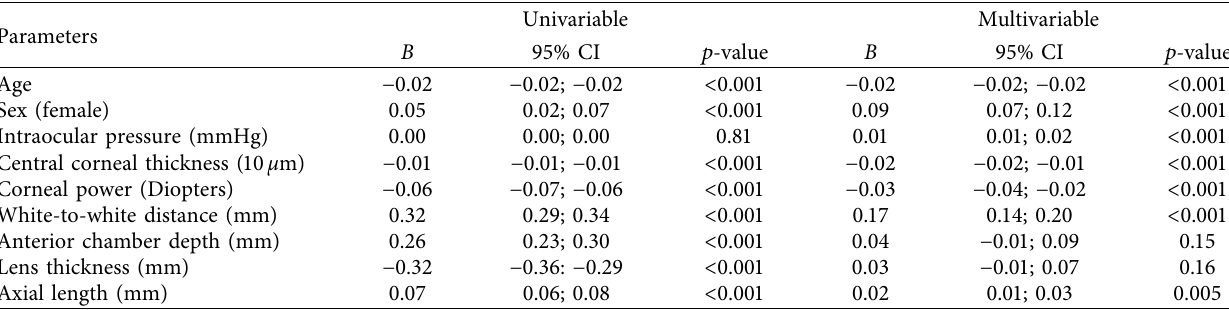
Table 3: Association analysis of ocular parameters and pupil size in phakic subjects. Data from the population-based Gutenberg Health Study in 2012–17 ( n � 16, 869 eyes).